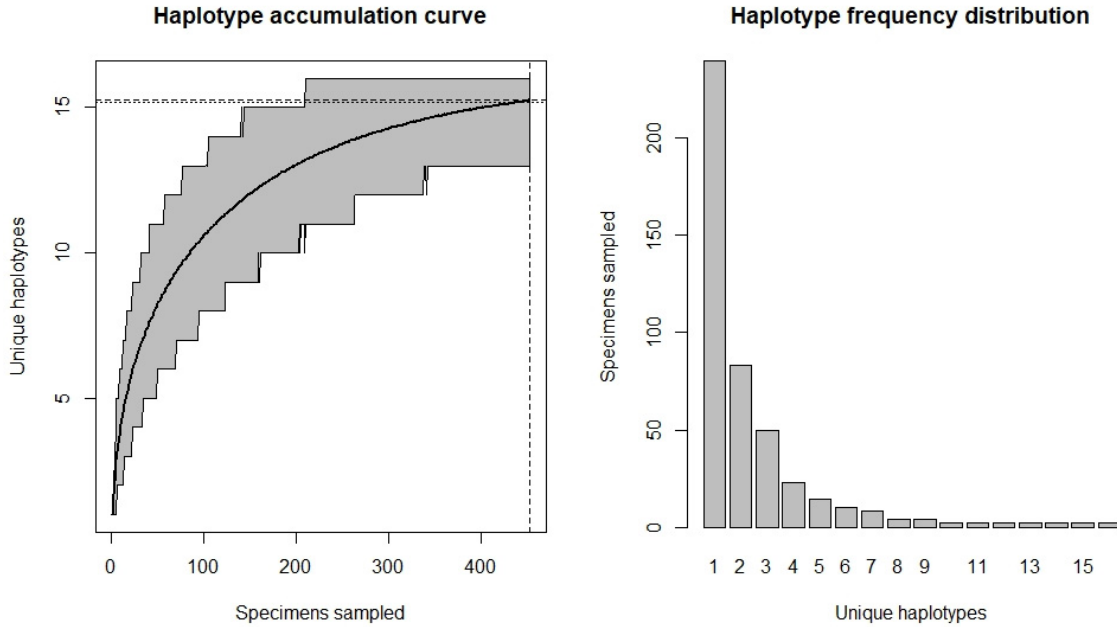
Figure A1. Output of a HACSim simulation of haplotype sampling based on the 16 haplotypes identified in this study.